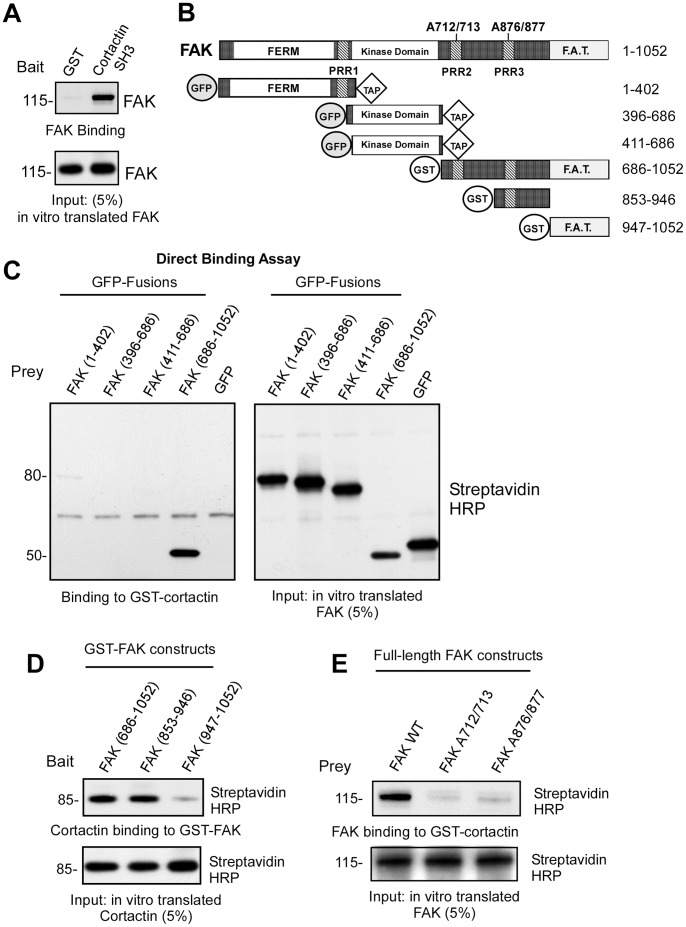
FAK PRR2 and PRR3 regions are direct binding sites for cortactin.(A) Cortactin SH3 domain binds FAK as determined by GST or GST-cortactin SH3 domain pulldown assays using in vitro translated FAK protein. FAK immunoblotting shows binding and 5% of input. (B) Schematic of FAK containing an N-terminal FERM domain, three PRR (PRR1-PRR3) sites, a central kinase domain, and a C-terminal FA targeting region. Point-mutations are indicated that disrupt PRR2 (A712/713) and PRR3 (A876/877). The indicated FAK regions (below) were used as bait or prey in direct binding assays as either GFP, C-terminal TAP, or GST fusion proteins. (C) FAK C-terminal domain binds cortactin. GFP fusions of FAK 1-402, FAK 396–686, and FAK 411–686 with a C-terminal TAP tag or non-tagged FAK 686–1052 were in vitro translated in the presence of biotin-lysine and used in a direct binding assay with GST or GST-cortactin attached to beads. Streptavidin-HRP analyses show the amount of FAK bound or 5% of prey material used in the binding assay. (D) FAK PRR3 region binds cortactin. In vitro translated full-length cortactin was incubated with GST-FAK (853–946) or GST-FAK (947–1052) in a direct binding assay. Streptavidin-HRP analyses show the amount of cortactin bound or 5% of prey material used in the binding assay. (E) FAK PRR2 and PRR3 are individually required for cortactin binding. GFP-fusions of FAK WT, A713/713, or A876/877 were in vitro translated and incubated with GST-cortactin in a direct binding assay. Streptavidin-HRP analyses show the amount of GFP-FAK bound or 5% of prey material used in the binding assay.